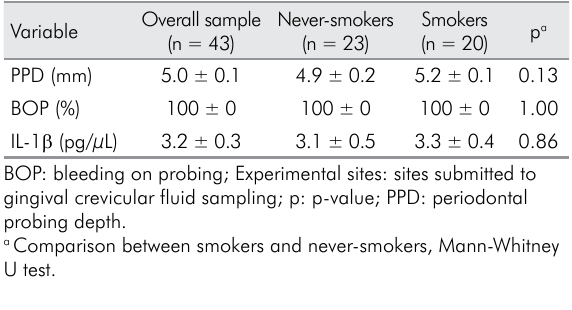
Table 1. Baseline data of the present sample considering only the experimental sites (mean ± standard